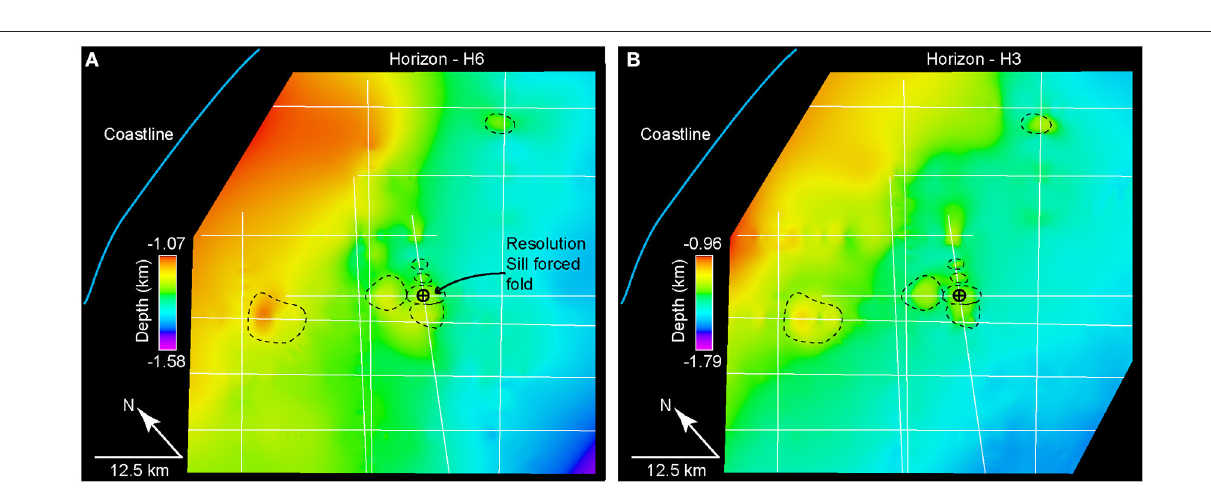
FIGURE 8 | (A,B) Depth-structure maps of horizons H6 and H3, highlighting the location of the Resolution-1 borehole and intrusion-induced forced folds (black dashed lines) in the vicinity. 2D seismic lines (white lines) also